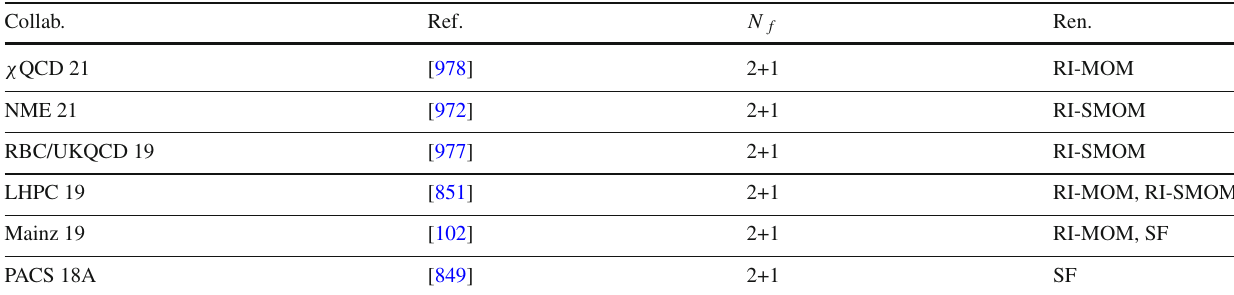
Table 181 Renormalization in determinations of the isovector axial, scalar and tensor charges with 2 + 1 quark flavours Collab.